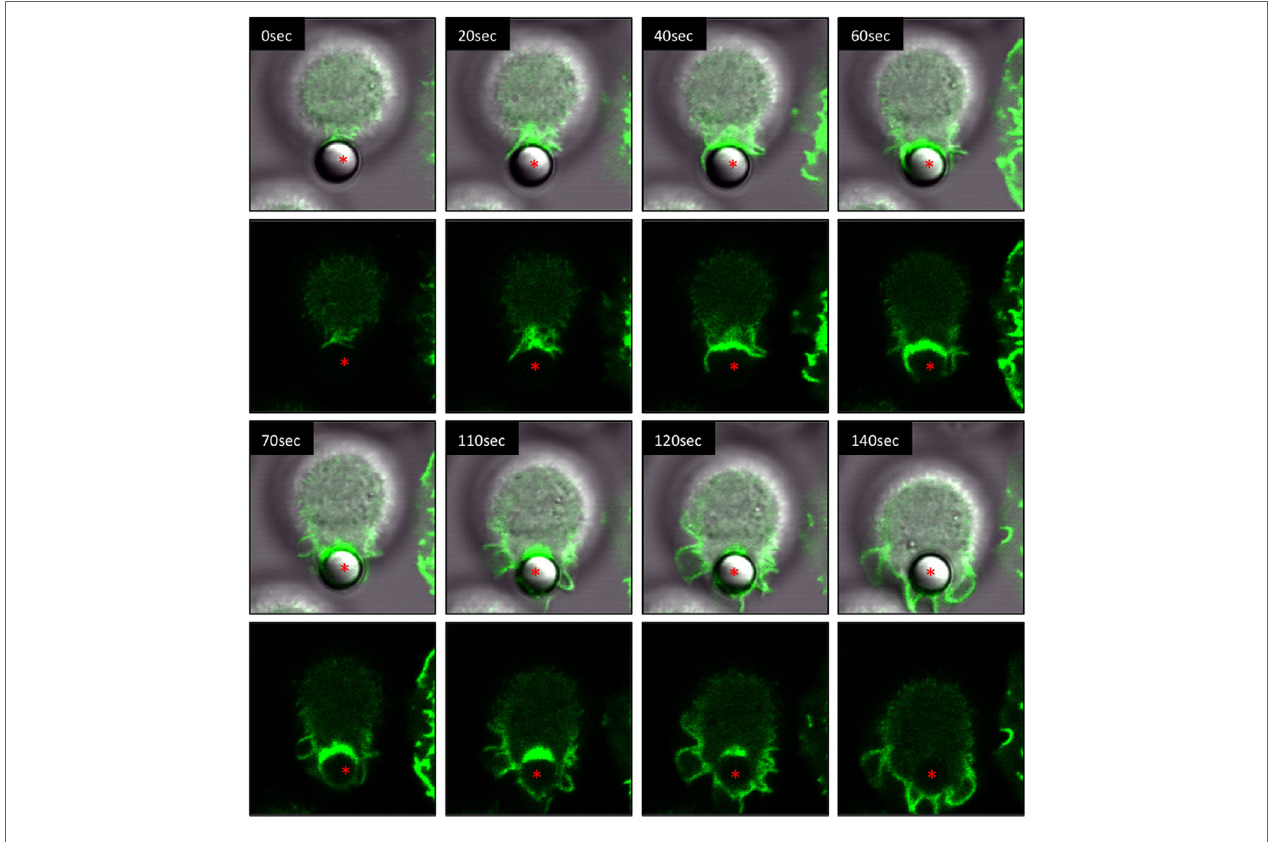
FigUre 2 | Live-cell imaging of IpLITR 2.6b/IpFcR γ -L-mediated phagocytosis. Rat basophilic leukemia-2H3 cells (3 × 10 5 ) stably co-expressing IpLITR 2.6b/ IpFcR γ -L and LifeAct-GFP were incubated at 37°C with 9 × 10 5 α HA monoclonal antibody-coated 4.5 µm microspheres. Immediately after the addition of target beads, images were collected at 10 s intervals for ~8 min using a Zeiss LSM 710 laser scanning confocal microscope (objective 60 × , 1.3 oil plan-Apochromat; Munich, Germany). Both the brightfield-LifeAct-GFP merged views (top panels) and the LifeAct-GFP views alone (bottom panels) are shown with the location of the target microsphere indicated with an asterisk. Representative time-stamps were extracted from Video S1 in Presentation 2 of Supplementary